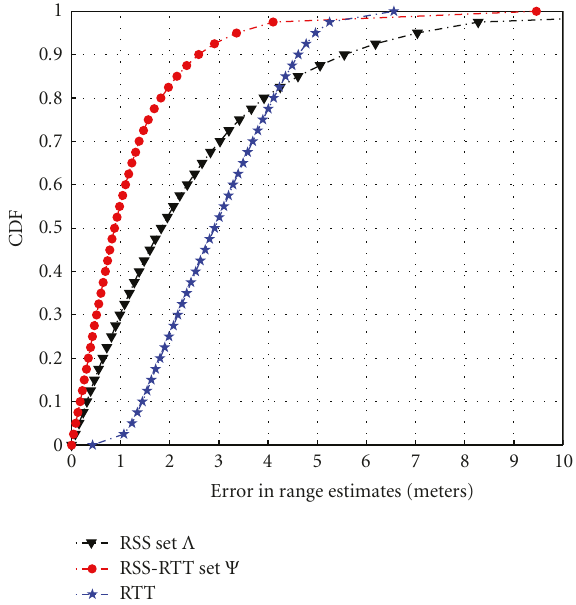
Figure 5: CDFs of errors in ranging estimate depending on the ranging method and set of constraints